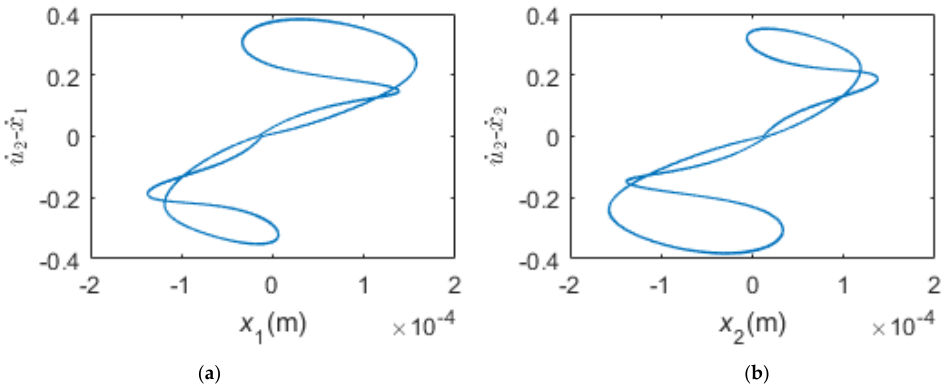
Figure 11. The relative velocity of the contact points versus displacements of the dampers, ( a ) left damper; ( b ) right damper.